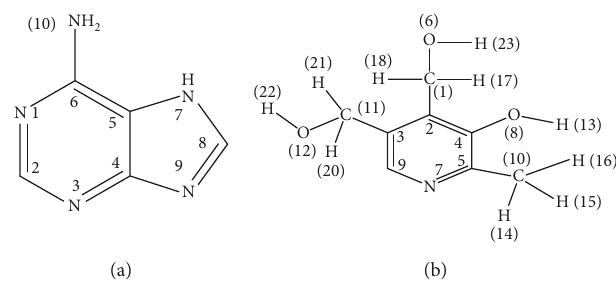
Figure 1: Chemical structure: (a) adenine; (b)